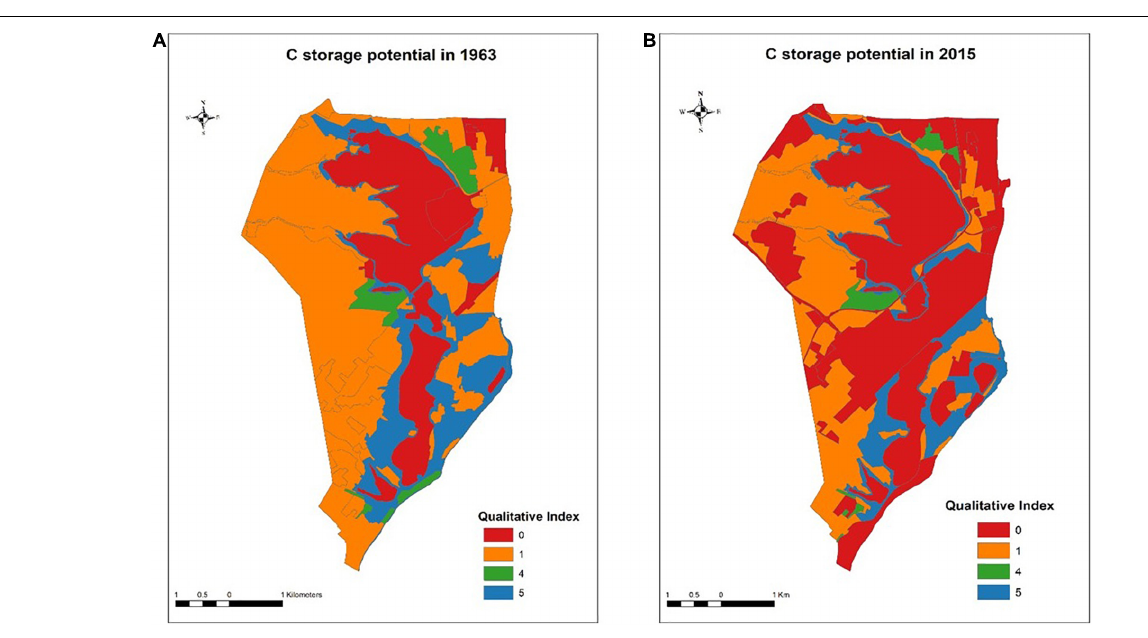
FIGURE 4 | Spatial distribution of the total Carbon storage in the study area and the changes during the period 1963 (A) to 2015 (B)